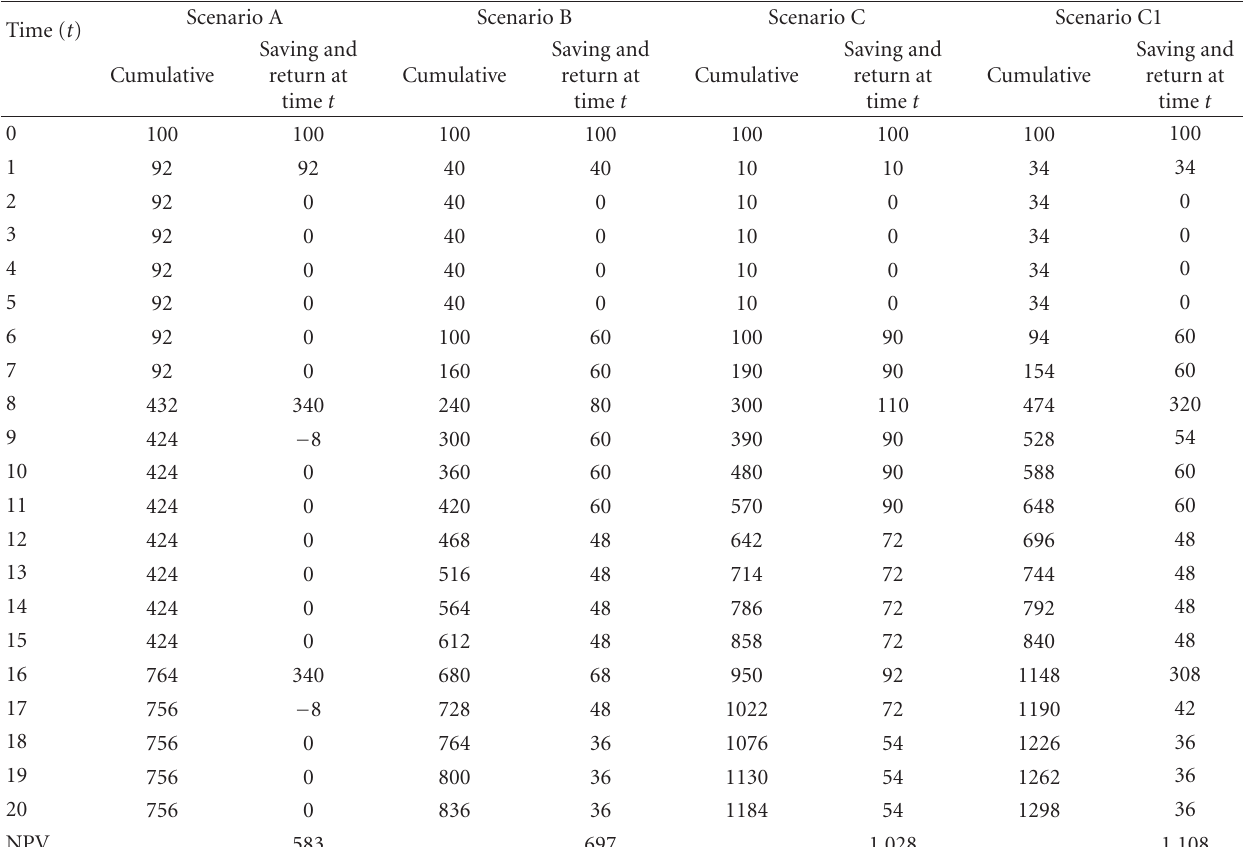
Table 6: Saving and returns for each scenario (million